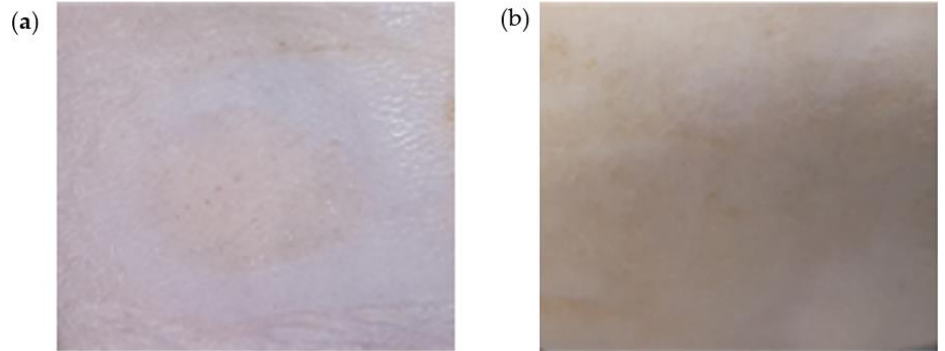
Figure 6. Images of skin stimulation and recovery after TA-DMN patch application: ( a ) image of the rat skin site 5 h after the application of the TA-DMN patch and ( b ) image of skin recovery 20 h after detachment of the TA-DMN patch.